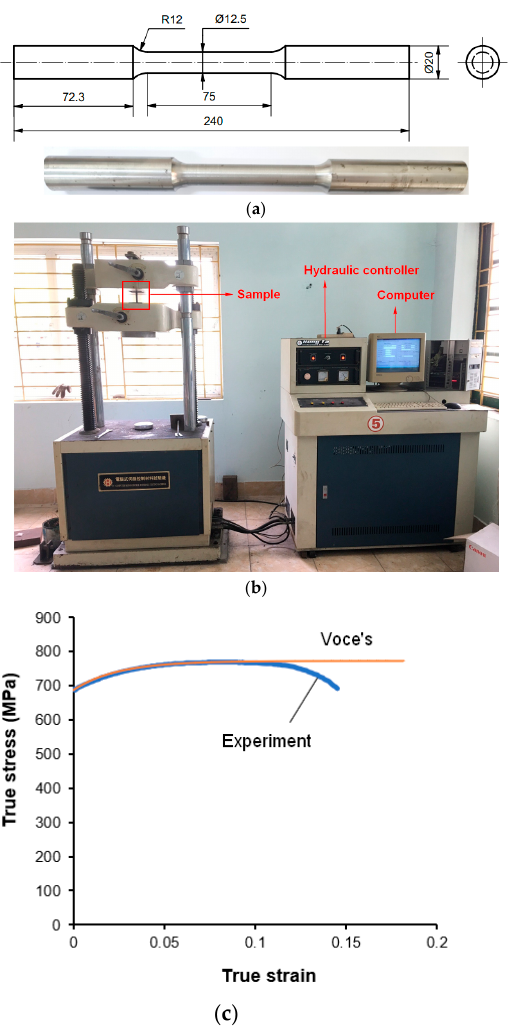
Figure 1. Tensile samples ( a ), Machine HUNGTA H-200A ( b ), and Stress-strain curve ( c ).